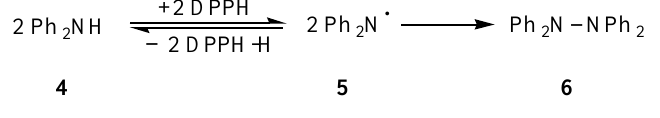
in benzene in the 2